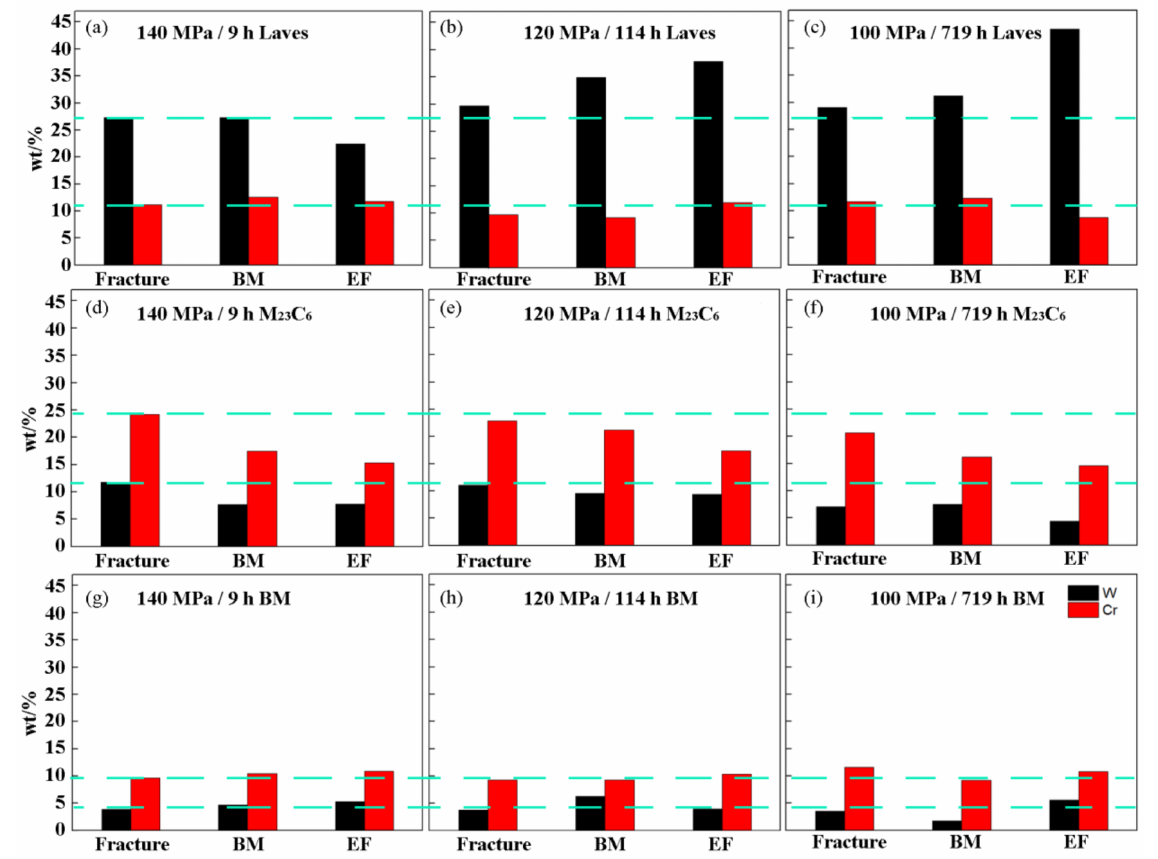
Figure 9. The statistical results of EDS W and Cr elements: ( a ) 140 MPa/9 h Laves; ( b ) 120 MPa/114 h Laves; ( c ) 100 MPa/719 h Laves; ( d ) 140 MPa/9 h M 23 C 6 ; ( e ) 120 MPa/114 h M 23 C 6 ; ( f ) 100 MPa/719 h M 23 C 6 ; ( g ) 140 MPa/9 h